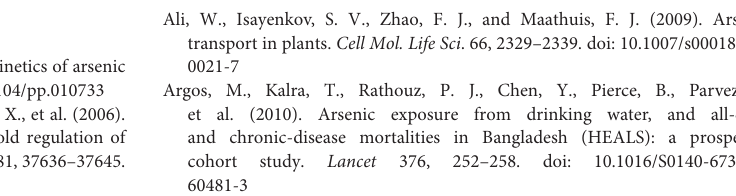
Figure S1 | Expression of OsARM1 pro ::GUS in the vascular cells of roots, leaves, and stems after As(III) treatment. (A,B) Transverse sections of roots (A) and leaves (B) showing GUS staining in the vascular cells. (C,D) Images showing the GUS staining in the epidermis of stems (C) and leaves (D) , respectively. Bars = 20 µ m. Figure S2 | Identification of the osarm1 T-DNA insertion mutant. (A) Location of T-DNA insertion site in OsARM1 in the osarm1 mutant (Os05g37060). Primer pairs XS830/XS831, XS830/PGVRB, and XS831/PGVRB were used to genotype the mutant. Primer pair XS147/XS148 was used to determine OsARM1 expression levels. E1 and E2 denote exon 1 and exon 2, respectively. (B) Genotyping analysis of osarm1 mutant by tri-primer PCR. All five independent plants are homozygous osarm1 mutants. (C) RT-PCR showing the expression levels of OsARM1 in various organs of wild type (DJ) and osarm1 . OsACTIN1 was used as a reference gene. P, panicle; G, grain; R, root; S, stem; L, leaf blade. Figure S3 | Phenotypes of OsARM1 mutants. The osarm1 seedlings showed reduced plant height (A) , panicle number (B) , and seed setting rate (C) compared to the wild-type DJ. But all the phenotypes mentioned above of OsARM1-KO lines were the same as wild-type NPB (D–F) . Asterisks indicate significant differences from wild type ( ∗∗ P < 0.01 by Student’s t -test). Figure S4 | Generation of OsARM1-KO transgenic lines. (A) Schematic diagram of the vector OsARM1 T 1 T 2 - Cas9 ( OsARM1 - KO ). (B) Genome editing efficiency of OsARM1-KO transgenic rice lines. Two independent transgenic lines containing a 1-bp insertion and 1-bp deletion, respectively, at the expected cleavage site were obtained. Figure S5 | Knockout of OsARM1 confers enhanced tolerance to low concentrations of As(III). (A,D) Phenotypes of 2-week-old wild-type DJ and osarm1 or wild-type NPB and OsARM1-KO transgenic lines ( KO-1 and KO-2 ) plants grown on Kimura B nutrient solution without (CK) or with 2 or 5 µ M As(III) for 14 days. During the treatment, renewed the treatment solution on the 7th day. (B,C) Relative root elongation (B) and relative plant height (C) of DJ and osarm1 plants after As(III) treatment in (A) . (E,F) Relative root elongation (E) and plant height (F) of NPB and OsARM1-KO s ( KO-1 and KO-2 ) after As(III) treatment in (D) . Asterisks indicate significant differences from wild type ( ∗ P < 0.05; ∗∗ P < 0.01 by Student’s t -test). Bars = 4cm.